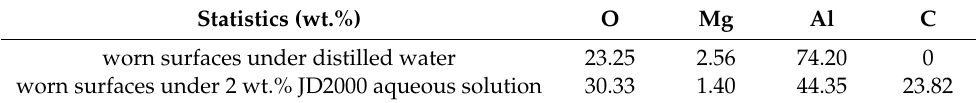
Table 2. Element contents of the friction-tested aluminum